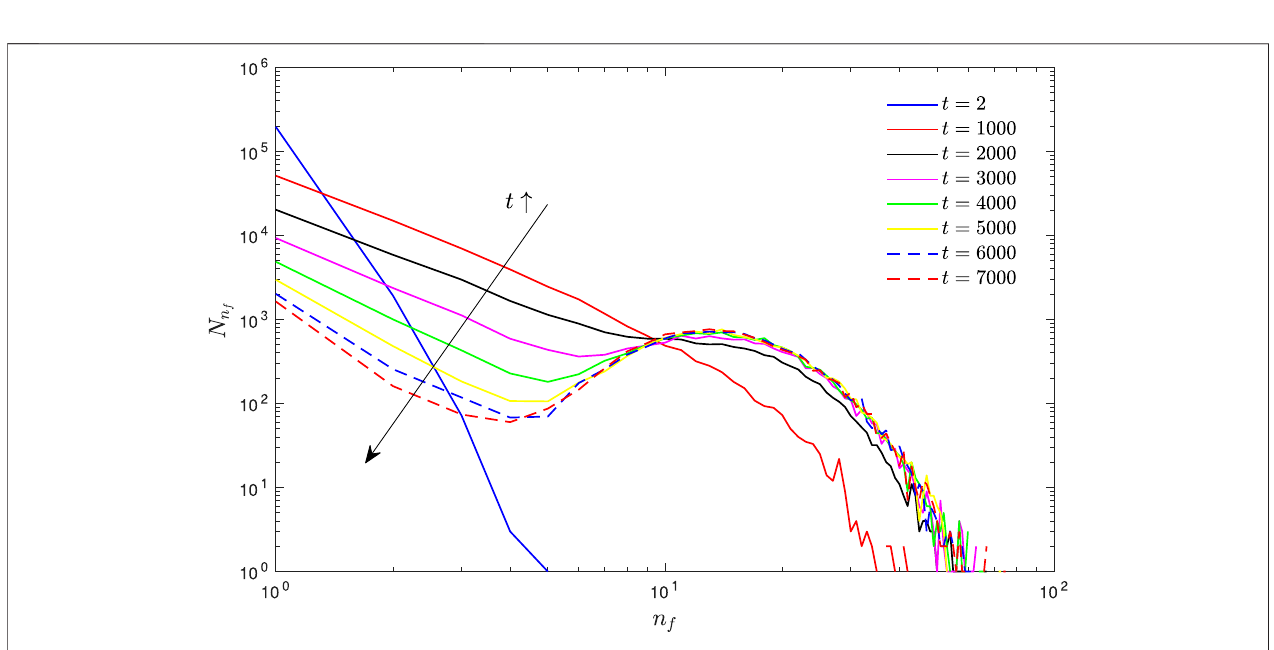
FIGURE 4 | Time evolution of the fl oc population N n